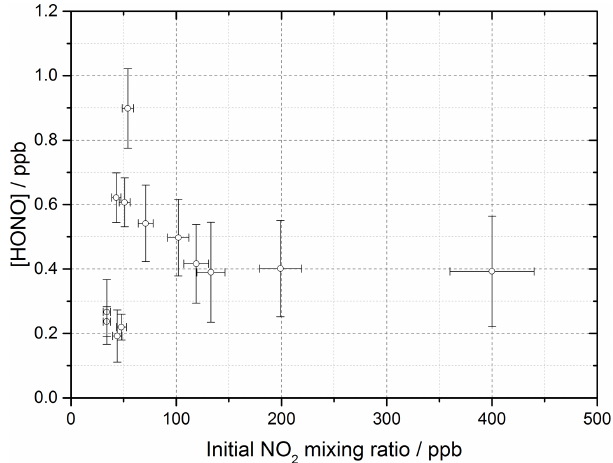
Figure 6. HONO concentration measured at the end of the flow tube as a function of the initial NO 2 mixing ratio, for the aerosol sur- face area density of (1.6 ± 0.8) × 10 − 2 m 2 m − 3 , relative humidity of 15 ± 1%, photon flux of (1.63 ± 0.09) × 10 16 photonscm − 2 s − 1 (290–400nm wavelength range), reaction time of 52 seconds and N 2 carrier gas. Each point is an average of up to 20 measurements at the same aerosol surface area and mixing ratio of NO 2 . The highest concentration of HONO measured was 0.90 ± 0.12ppb at [NO 2 ] = 54 ± 5ppb. The y error bars represent 1 σ , while the x er- ror bars represent the sum in quadrature of the errors in the N 2 and NO 2 gas flows and the NO 2 dilution. The SA varied over the exper- iments at different NO 2 mixing ratios leading to a larger error in the quoted SA.